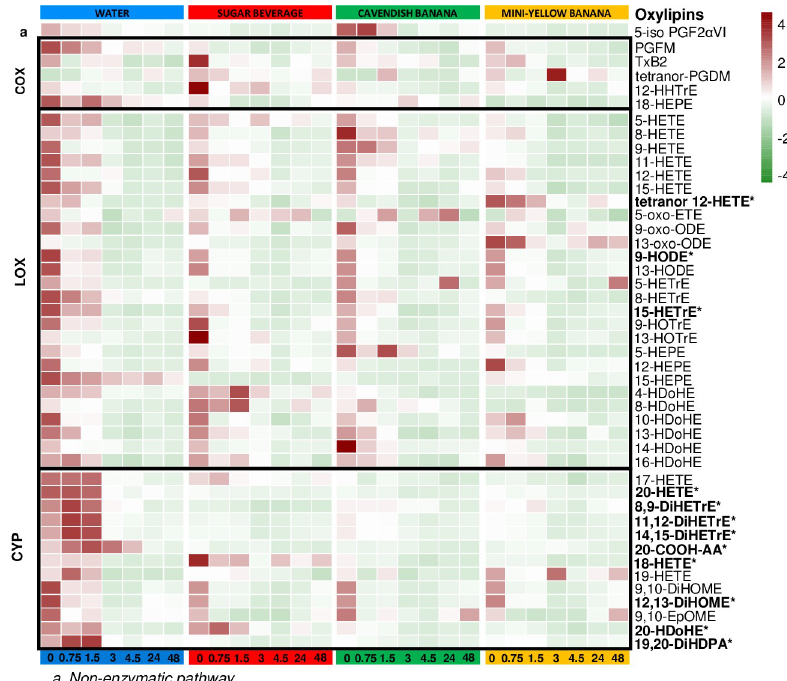
Fig 5. Heat map displaying oxylipin responses to exercise (ratios using pre-exercise values) in each of the four trials using Z scores. The data support a strong exercise-induced increase in plasma oxylipins during the water trial, with carbohydrate ingestion attenuating oxylipin increases, especially those generated from the P-450 cytochrome enzyme system. � P < 0.05, interaction effect.